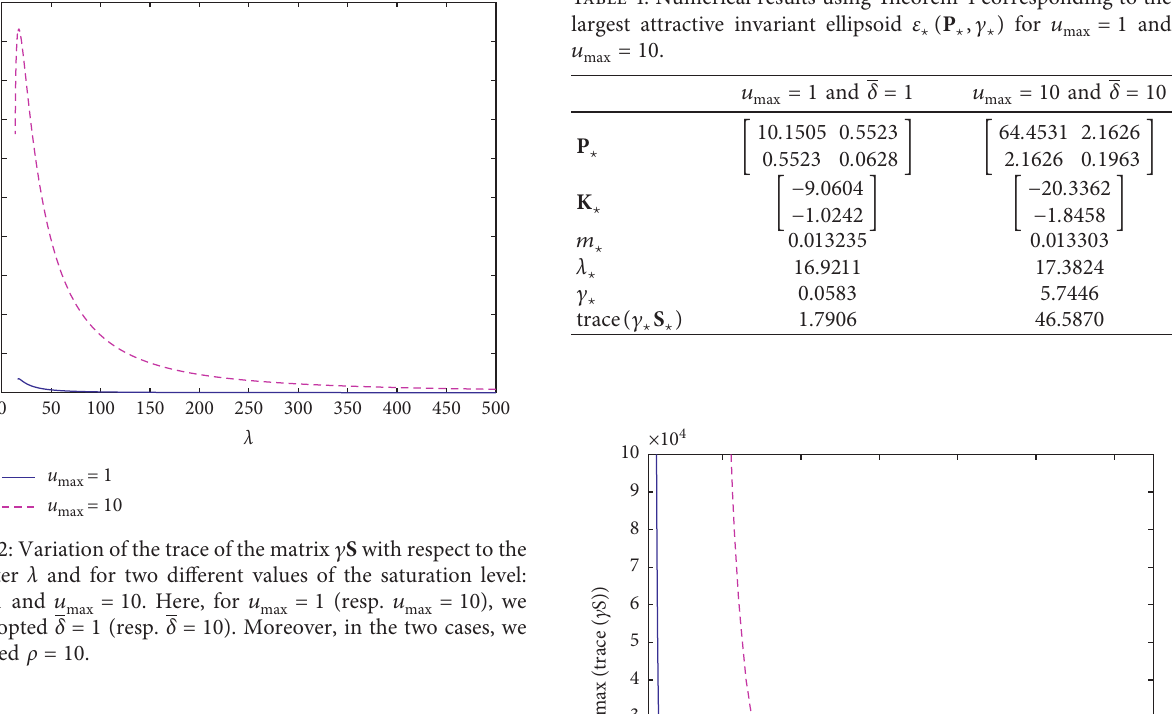
Table 4: Numerical results using Theorem 4 corresponding to the